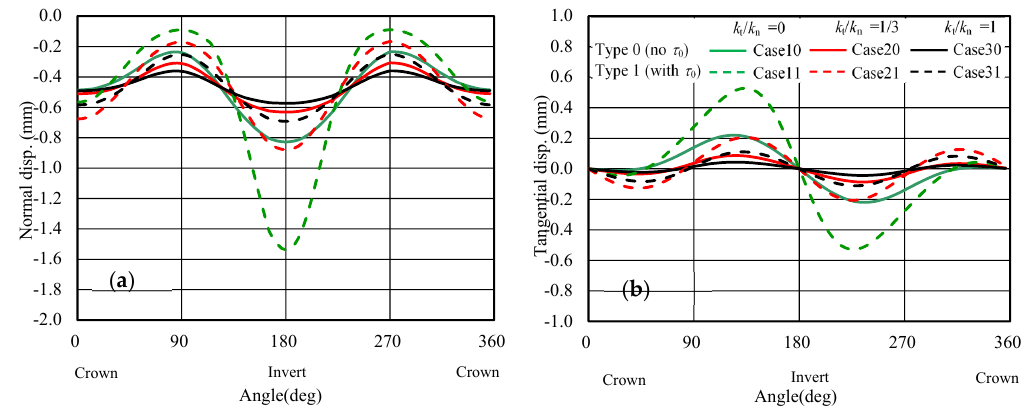
Figure 10. Lining displacement for ground at k n = 1000 MN/m 3 (deep tunnel). ( a ) Normal displacement (+: outward); ( b ) Tangential displacement (+: counterclockwise).